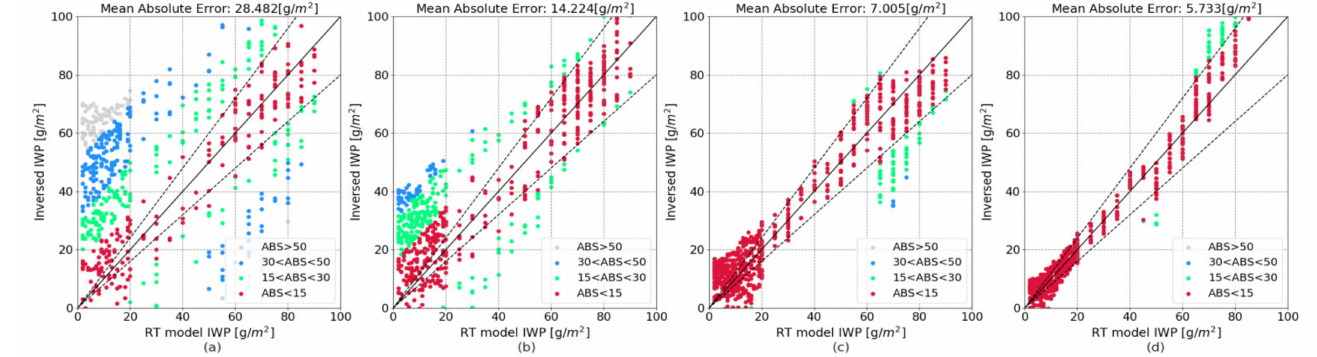
Figure 5. The single-channel IWP inversion results. ( a ) 325.15 ± 9.5 GHz channel; ( b ) 448.0 ± 3.0 GHz channel; ( c ) 664.0 ± 4.2 GHz channel; ( d ) 874.4 ± 6.0 GHz